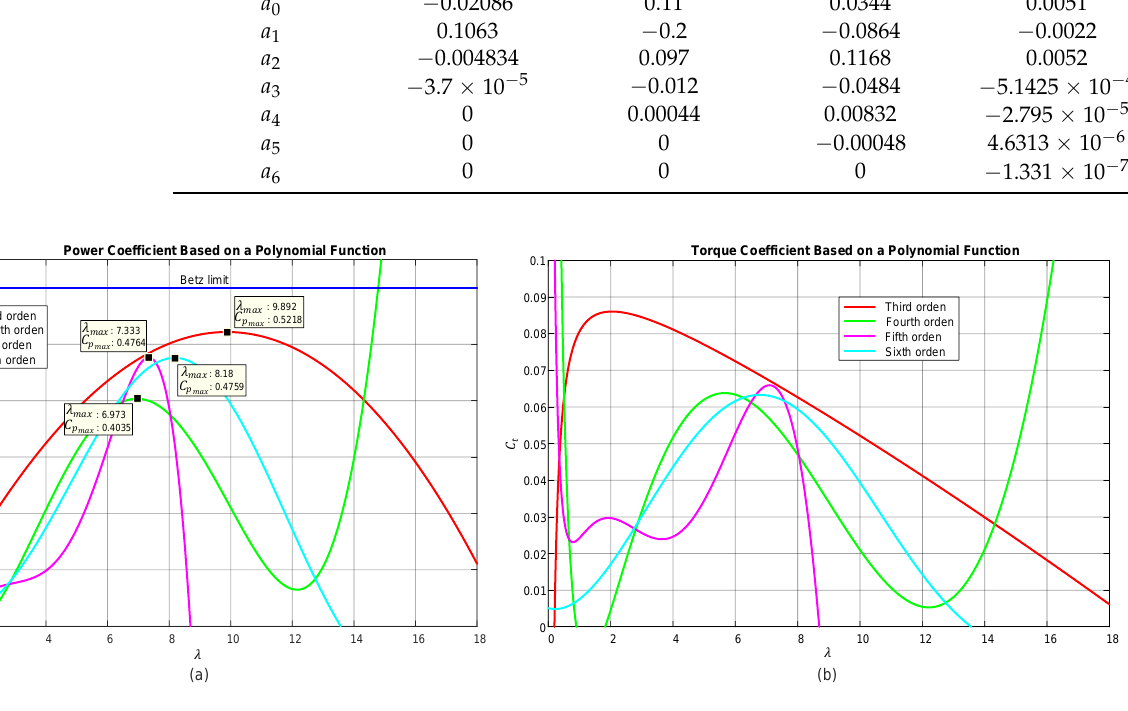
Figure 5. Coefficients based on a polynomial function; ( a ) power coefficient, ( b ) torque coefficient.